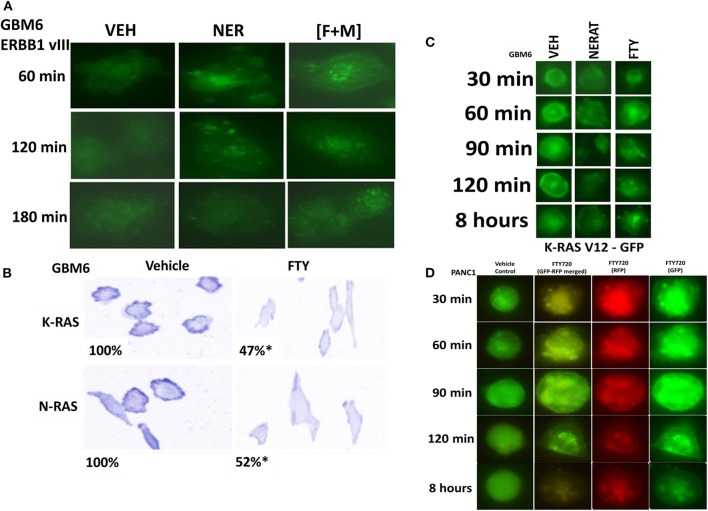
[FTY + MMF] exposure causes intracellular clustering of ERBB1 vIII and the degradation of RAS proteins. (A) GBM6 cells that express ERBB1 vIII were treated with vehicle control (VEH), neratinib (100 nM), or [fingolimod (FTY, 100 nM) + MMF (5 μM)] in combination. Cells were fixed in place at the indicated time points and the localization of ERBB1 vIII determined using an antibody raised against the COOH terminal portion of ERBB1. (B) GBM6 cells were treated with vehicle control (VEH) or with fingolimod (FTY, 100 nM) for 6 h. Cells were fixed in place and immuno-staining performed to detect the expression and localization of K-RAS and N-RAS. Analyses for densitometric scanning of fluorescence intensity were performed at 10X magnification on >120 cells per condition (n = 3 ± SD) *p < 0.05 less than exposure in vehicle control. (C) GBM6 cells were transfected with a plasmid to express K-RAS V12–GFP. Twenty-four hours later, cells were treated with vehicle control (VEH), fingolimod (FTY, 100 nM) or with the irreversible ERBB1/2/4 inhibitor neratinib (100 nM) for 0.5–8 h. Cells were imaged at 60X magnification and representative images from each condition at each time point are presented. (D) PANC1 pancreatic cancer cells that express an endogenous mutant K-RAS were transfected with plasmids to express K-RAS V12–GFP and K-RAS V12–RFP. Twenty-four h after transfection cells were treated with vehicle control or with fingolimod (FTY720, 100 nM) for the indicated time points. Cells were imaged at 60X magnification in the Hermes WiScan microscope and images were merged in Photoshop CS5.